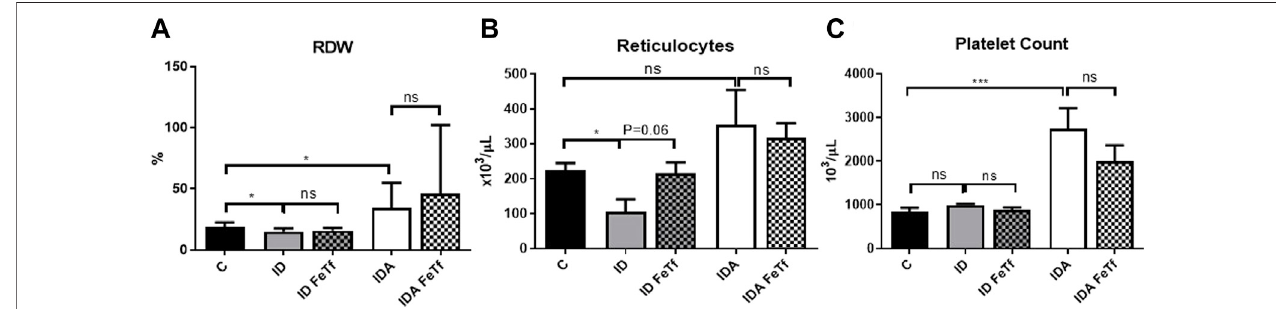
FIGURE 5 | Mice with iron de fi ciency anemia demonstrate suppressed erythropoietic activity and enhanced thrombopoiesis. ID and IDA mice were treated with carrier orholotransferrin. (A) Redcelldistribution width, (B) reticulocytecountsand (C) plateletcountsweremeasured.Controlmicefedastandard250 ppmFedietare included for reference. For control mice n = 16, for ID cohorts n = 6 – 11 and for IDA cohorts n = 6-7 mice per group. ppm, parts per million; data represented as mean (SEM).*, p < 0.05; ***, p < 0.005; ****, p < 0.001; ns, non-signi fi cant.